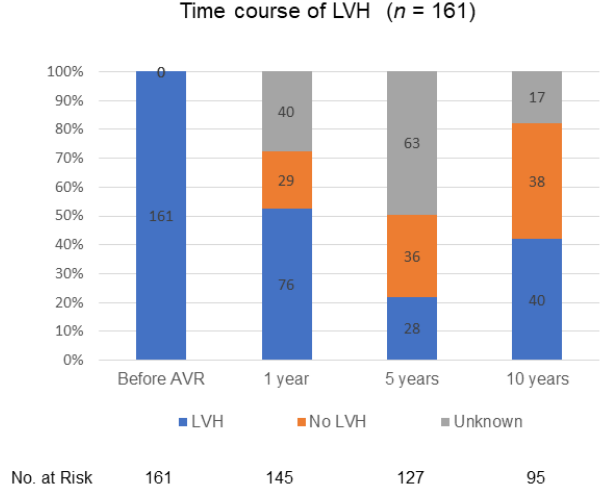
Figure 4. Time course of LVH during 10 years of follow-up, after excluding the patients with a history of hypertension. LVH: left ventricular hypertrophy. AVR: aortic valve replacement.